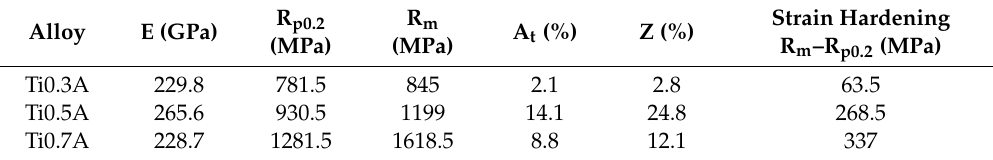
Table 6. The average results of the tensile tests carried out on Ni 1,5 Co 1,5 CrFeTi x